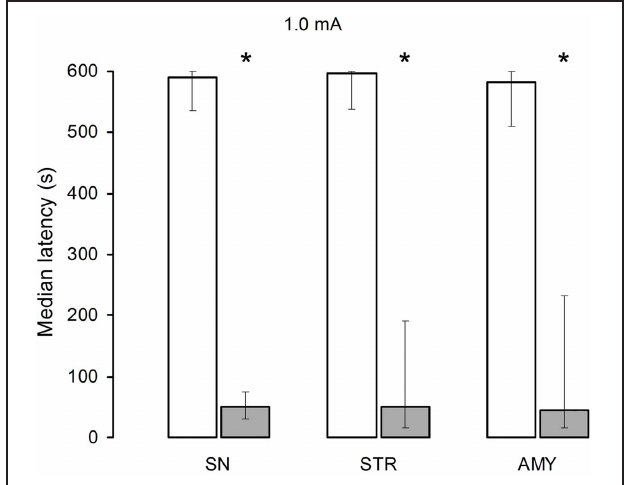
FIGURE 2 | Median retention scores (with interquartile range) of groups of rats trained in one-trial inhibitory avoidance and injected with either isotonic saline solution (open bars) or 2% lidocaine (filled bars). Lidocaine infusion into the substantia nigra (SN), striatum (STR), or amygdala (AMY) produced amnesia in animals trained with 1.0mA. ∗ p < 0 . 05 between saline and